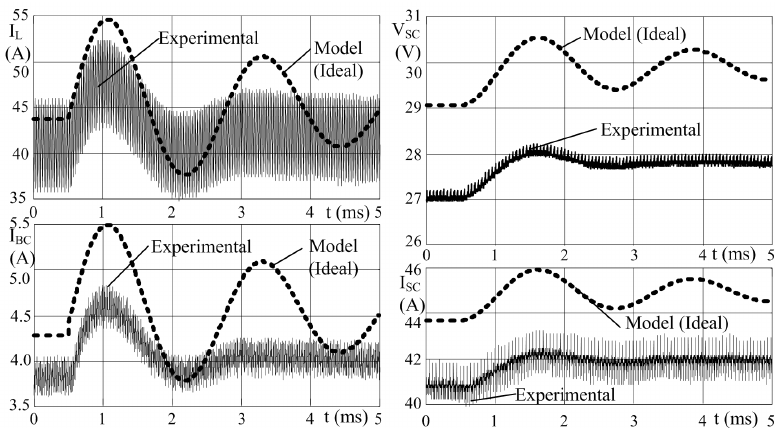
Figure 20. Experimental waveforms (gray) and averaged value of model based on ideal components (black, dashed), for filter current ( I L ), load output current ( I SC ), load voltage ( V SC ), and input current ( I BC ).